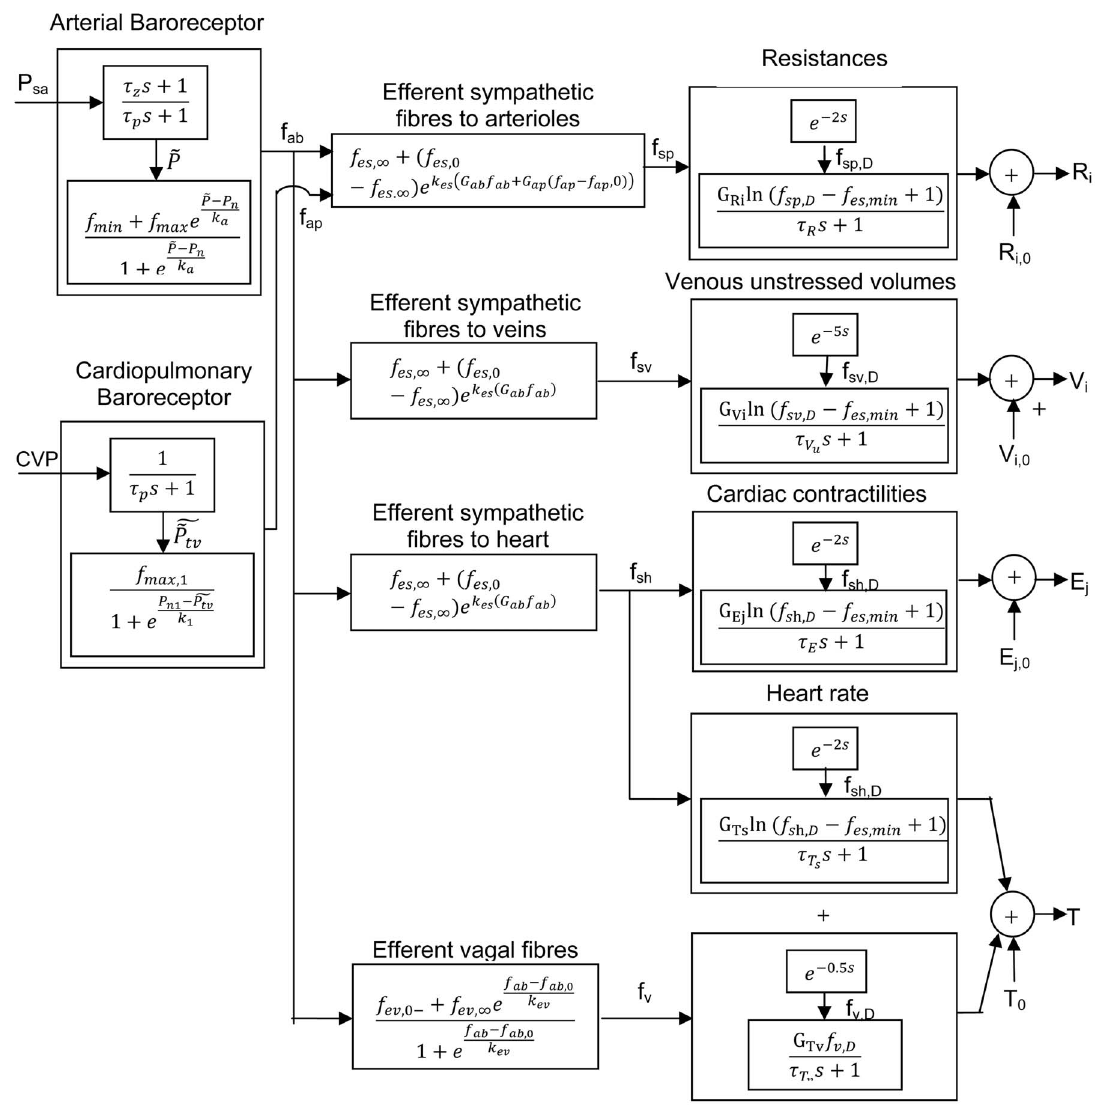
Figure 2. Block diagram of the complete reflex model. P sa : systemic arterial pressure; CVP : central venous pressure; f ab & f ap : afferent activities from the arterial and cardiopulmonary receptors respectively; f sp , f sv & f sh : efferent sympathetic activities directed to the systemic resistances, veins and heart respectively; f v : efferent vagal activity; R i & V i : systemic resistances and venous unstressed volumes (i = splanchnic,renal,upper body,lower body); E j : cardiac contractilities (j = left ventricle, right ventricle); T : heart period.